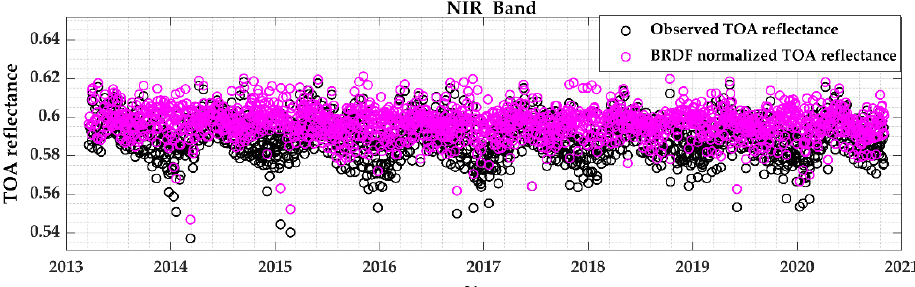
Figure 7. Comparison of the observed TOA reflectance and the bidirectional reflectance distribu- tion function (BRDF)-normalized TOA reflectance of Sentinel 2A.